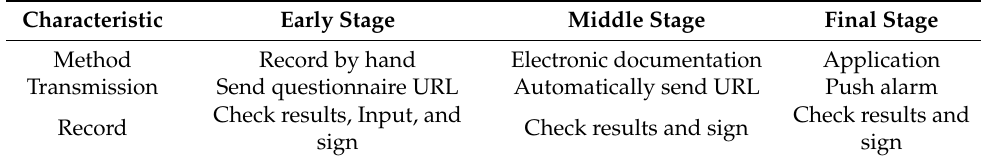
Table 2. Changes in the medical